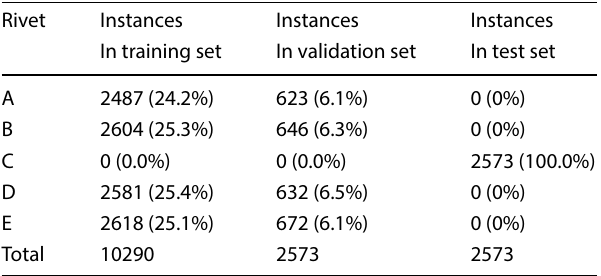
Table 4 Exemplary rivet distribution when one rivet (here it is Rivet C) is used as a hold-out set. Experiments with Mix4 suggested that approximately 16×10 3 samples should be enough for the contex- tual task and data